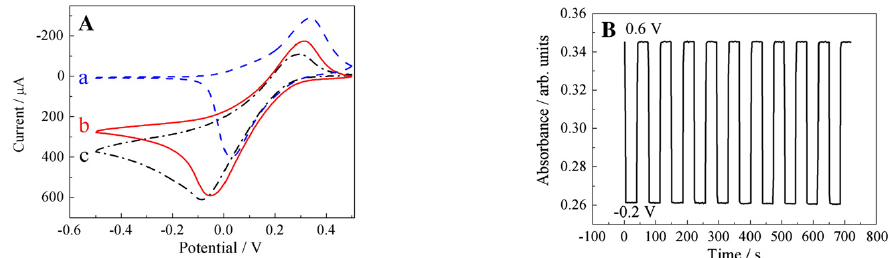
Figure 13. Electrochemical operation of the sensor built by the layer-by-layer complexation method. ( A ) Cyclic voltammograms of [PB/PEI–graphene] 10 multilayer ( a ) in N 2 -saturated potassium hydro- gen phthalate (0.1 M, pH = 4), [PB/PEI–graphene] 10 multilayer; ( b ) and [PB/PEI] 10 multilayer; ( c ) in the presence of 5 mM H 2 O 2 in N 2 -saturated potassium hydrogen phthalate. Scan rate: 10 mV/s; ( B ) spectroscopic monitoring of potential switching for [PB/PEI–graphene] 16 multilayer film immersed in a quiescent cuvette cell. Switching occurred between − 0.2 V (Prussian white, low absorbance) and 0.6 V (Prussian blue, high absorbance). With permission from